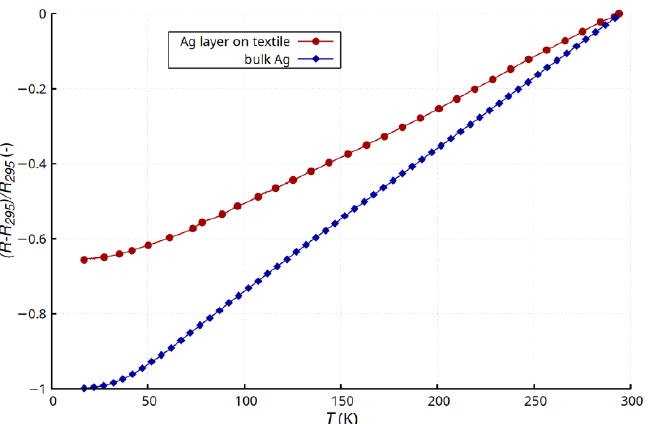
Figure 4. Comparison of relative changes in resistance and temperature of a thin Ag layer created on Cordura substrate and bulk Ag.